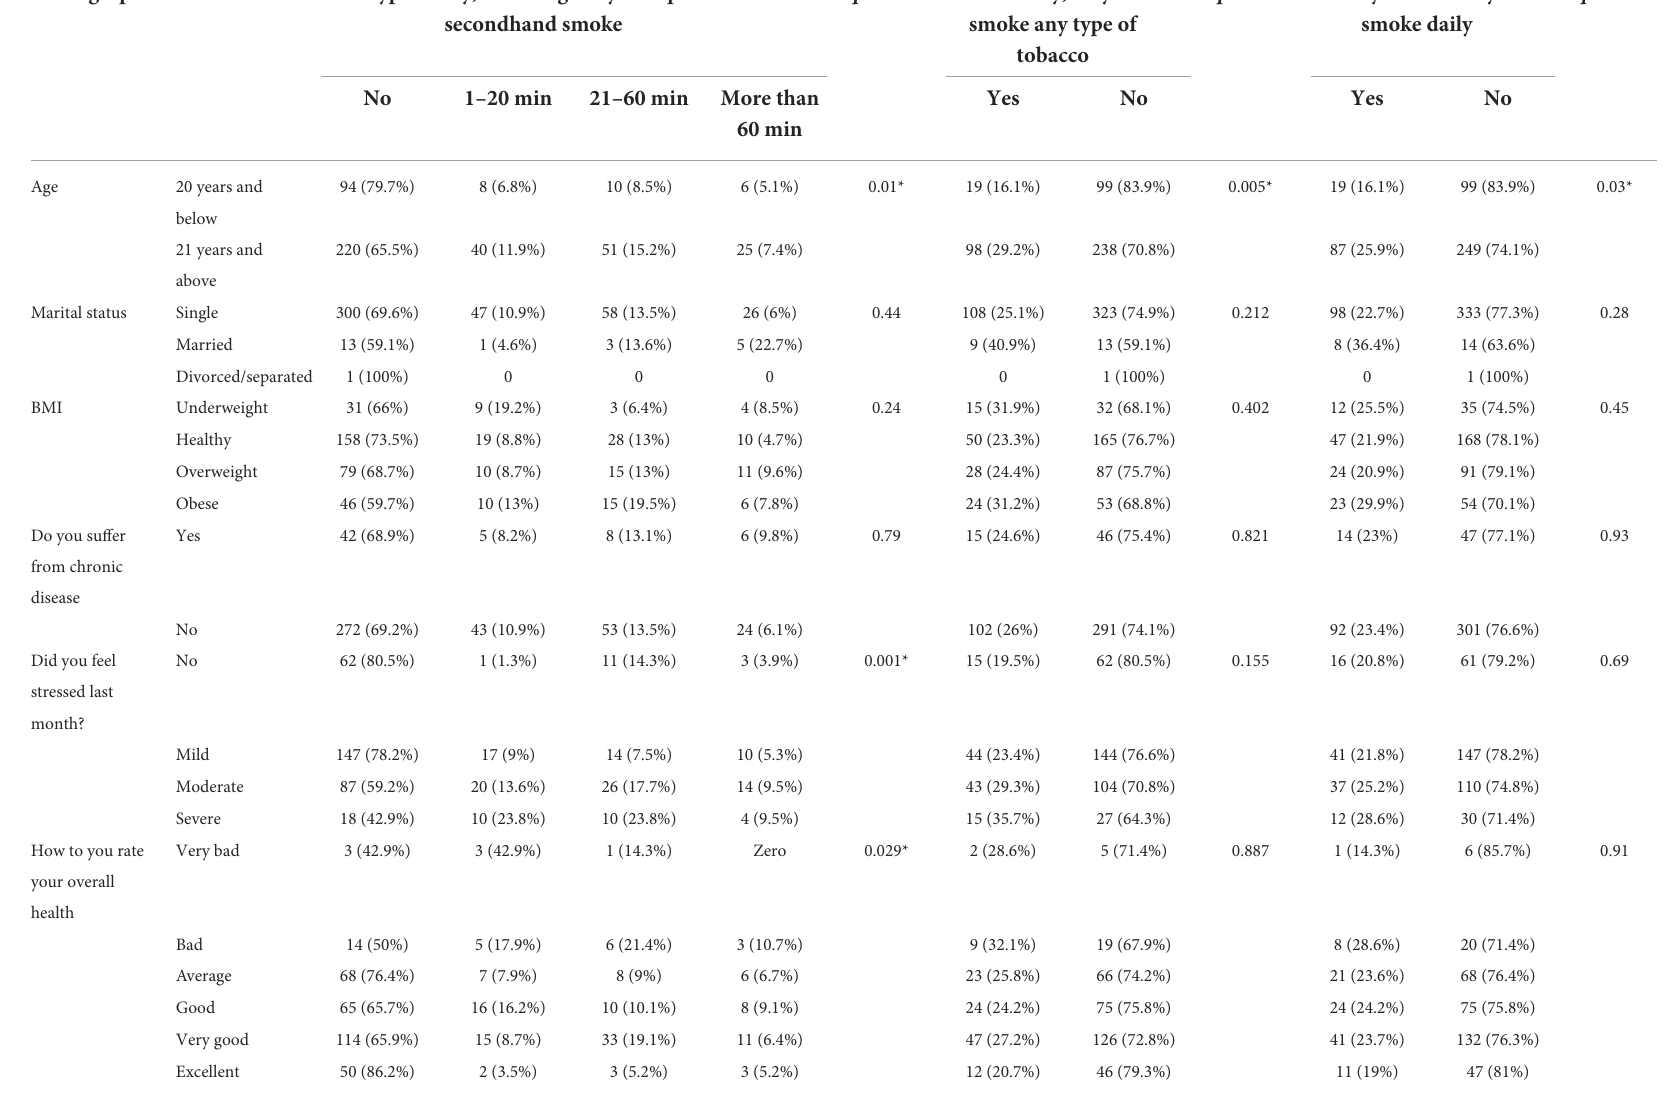
TABLE 5 Tobacco smoking and exposure to secondhand smoke among male students of Najran University. Demographic